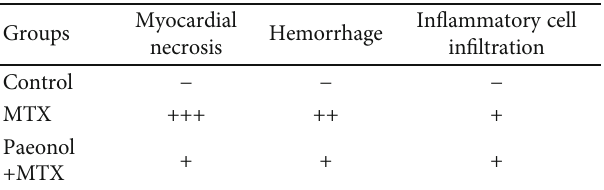
Table 1: E ff ect of paeonol on the severity of histopathological lesions in methotrexate- (MTX-) induced cardiac toxicity in